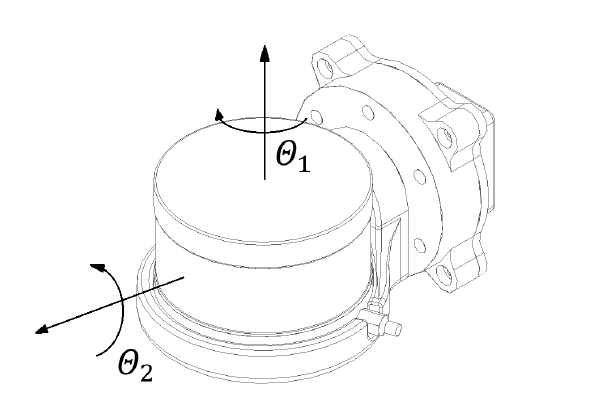
Figure 2. Lidar rotation module scheme. Θ 1 represents inner laser rotation around the vertical axis and Θ 2 denotes external rotation of the entire sensor around its longitudinal axis using an